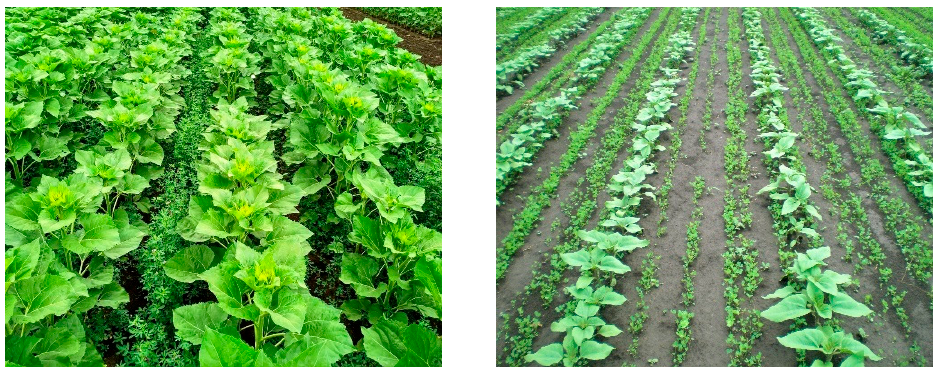
Figure 1. Spatial arrangement of the sunflower legume intercropping (six rows of legumes between two sunflower